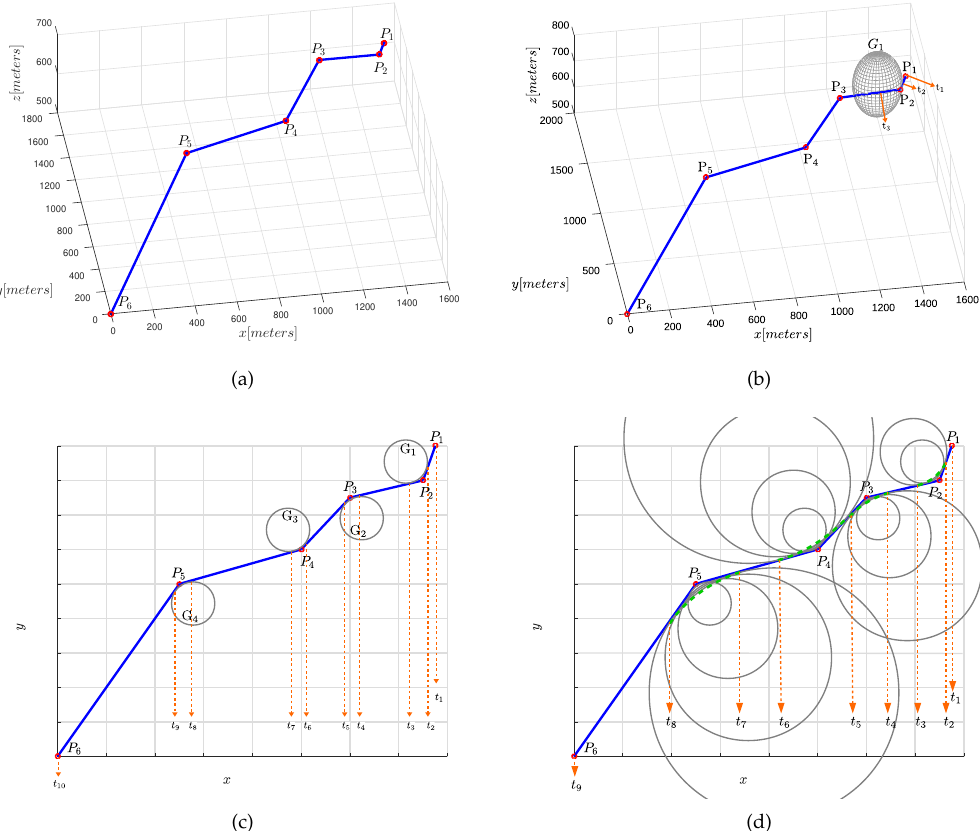
Figure 2. Smooth path planning problem. The red dots represent ρ and the blue line is the path made up of straight-lines LLL ( t ) . ( a ) Result of path planning with ρ collision-free points. ( b ) Definition of a sphere with a relation of the Rp minimum. ( c ) Set of G i over ρ . ( d ) Example of optimal smooth trajectory, with optimized κ and τ represented by dotted green lines in orthogonal view.